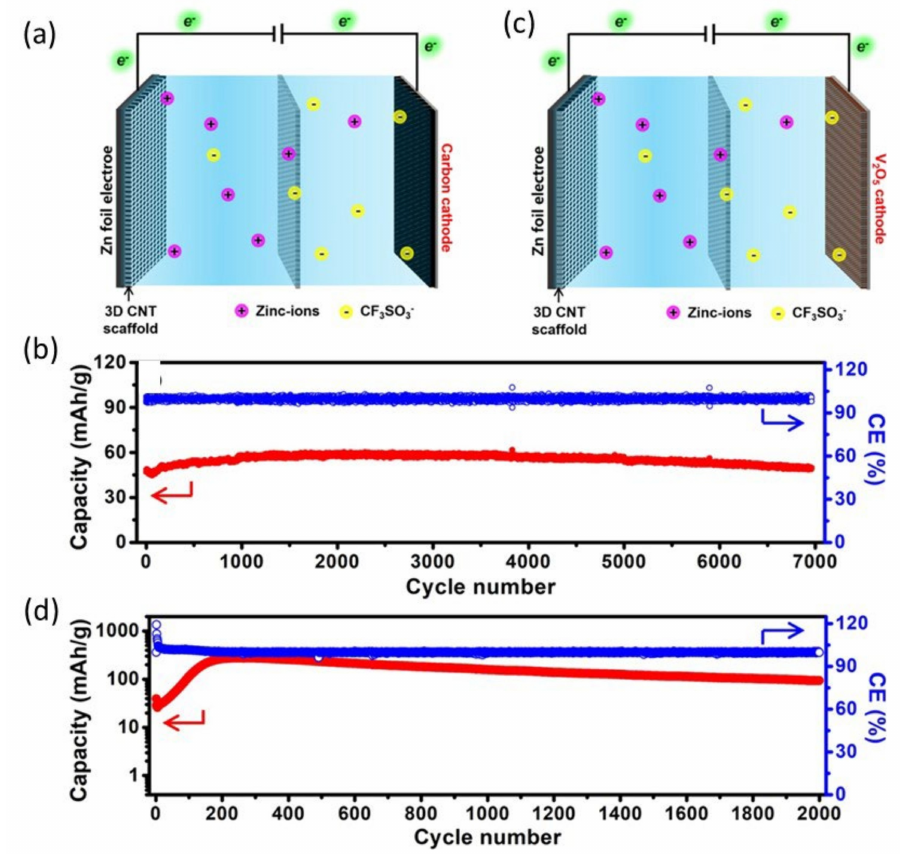
Figure 17. ( a ) Schematics, ( b ) cycling performance of activated carbon|Zn(CF 3 SO 3 ) 2 |Zn@CNTS ZICs, ( c ) schematics, and ( d ) cycling performance of Zn@CNTS|Zn(CF 3 SO 3 ) 2 |V 2 O 5 ZIBs. Reprinted with permission from Ref. [105]. Copyright 2020